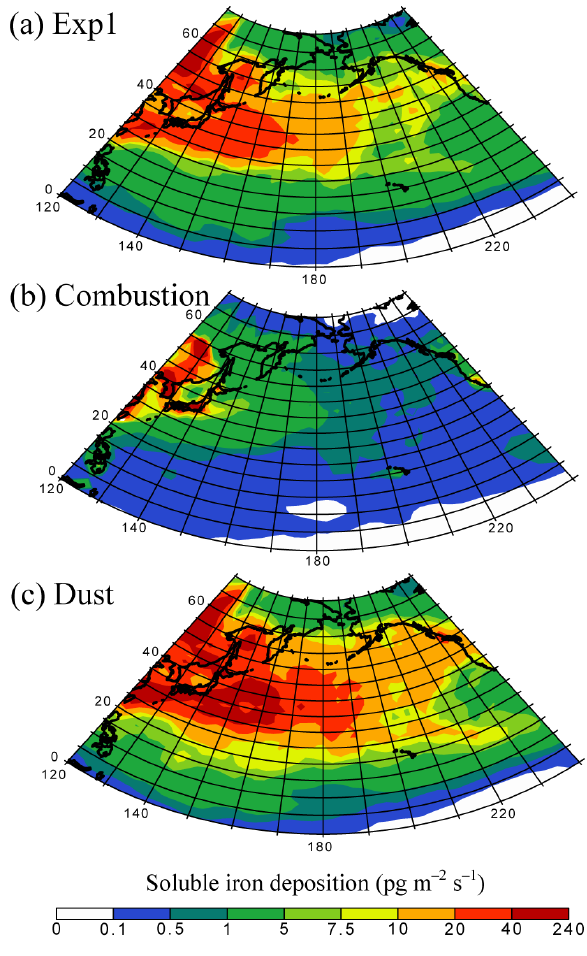
Fig. 7. Average soluble iron deposition (pg m − 2 s − 1 ) to the ocean from (a) dust source (Exp1), (b) combustion source, and (c) dust source with combination of Exp1 for coarse mode and Exp2 for fine mode during April